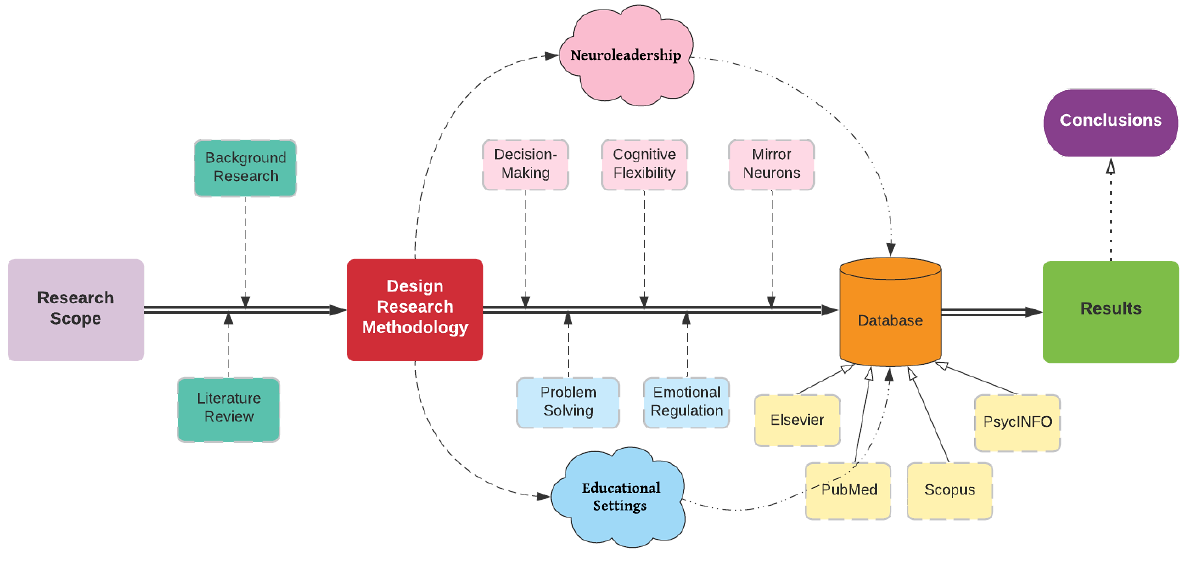
Figure 1. Research Methodology